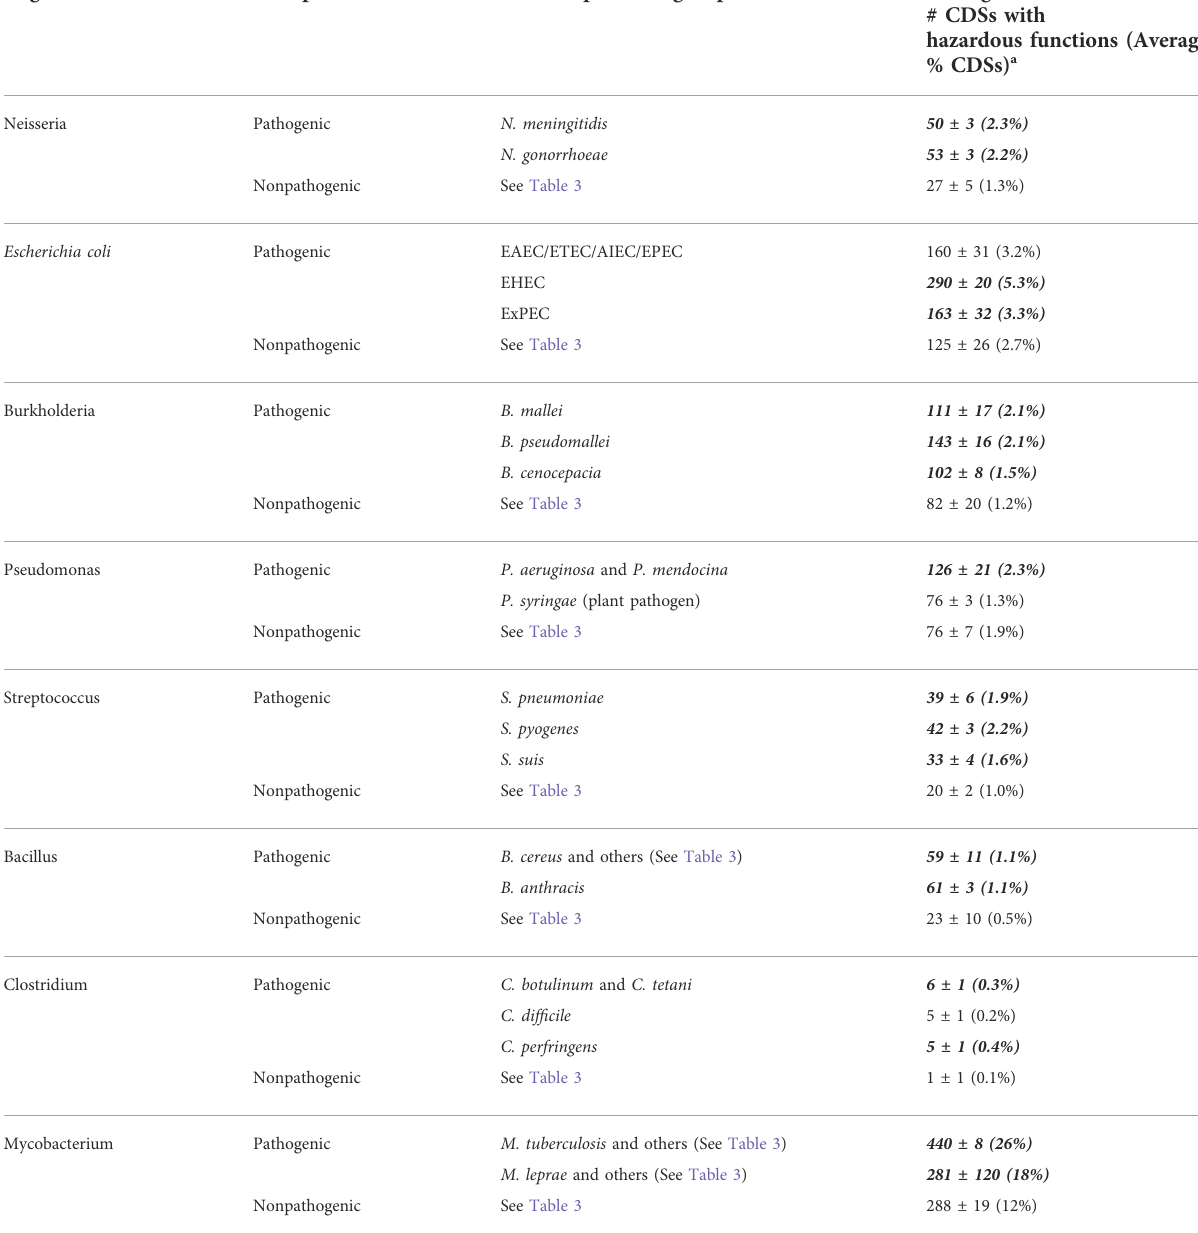
TABLE 2 The average number and percentage of hazardous CDSs are greater in pathogenic groups compared to nonpathogenic Groups.